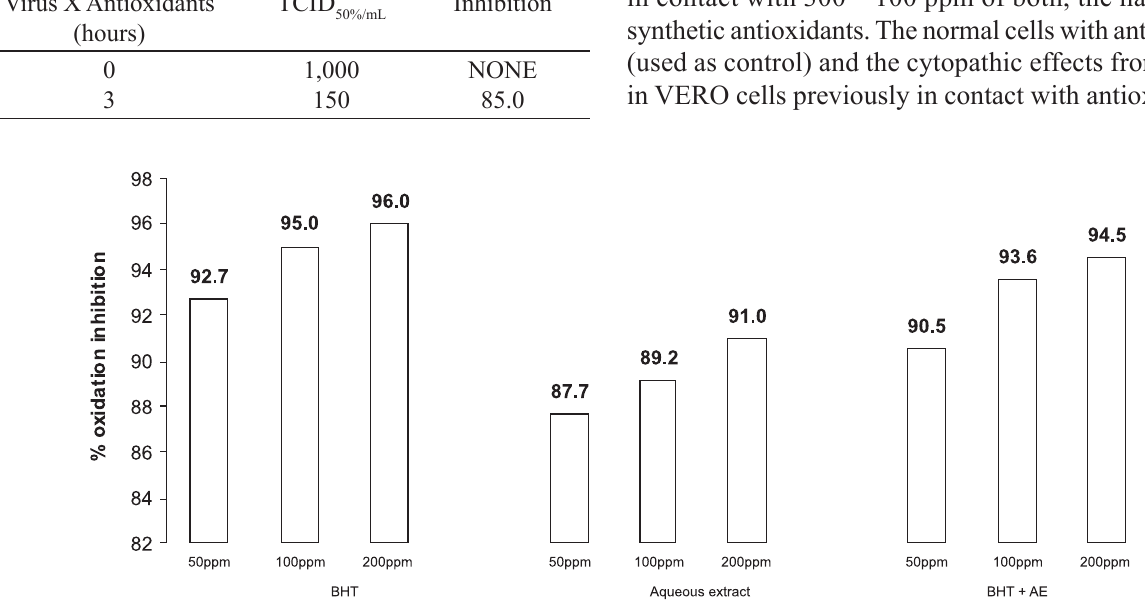
FIgURE 1 – Percents of the oxidation inhibition from BHD and aqueous extracts (AE) of rosemary ( Rosmarinus officinalis L . ) and its synergic